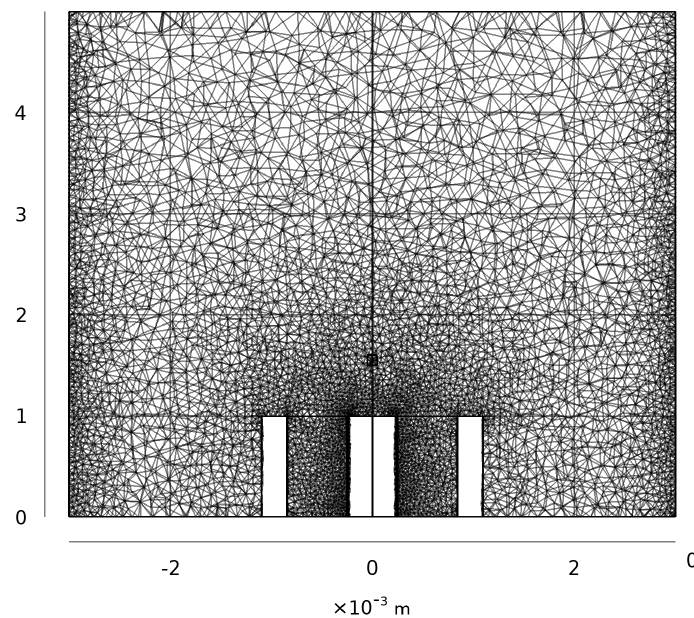
Figure 2. Cross-sectional view of the finite element mesh for an inclusion 0.1 mm on a side. Unmeshed areas represent the metallic center conductor and outer conductor